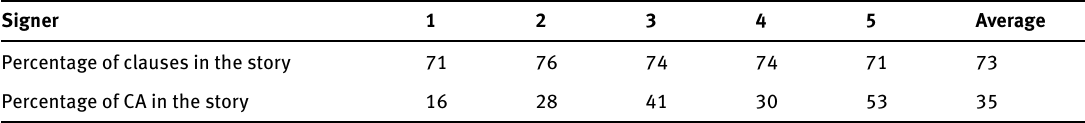
Table 2. Percentage of verbal-centered clauses and CA in the